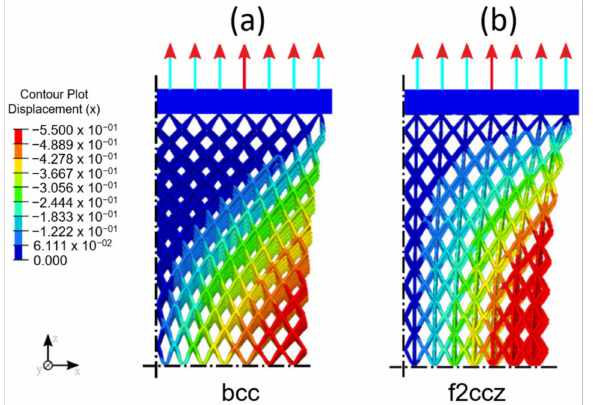
Figure 8. Sample without transition area—displacement in the x-direction of bcc ( a ) and f2ccz ( b ) structures—lateral view